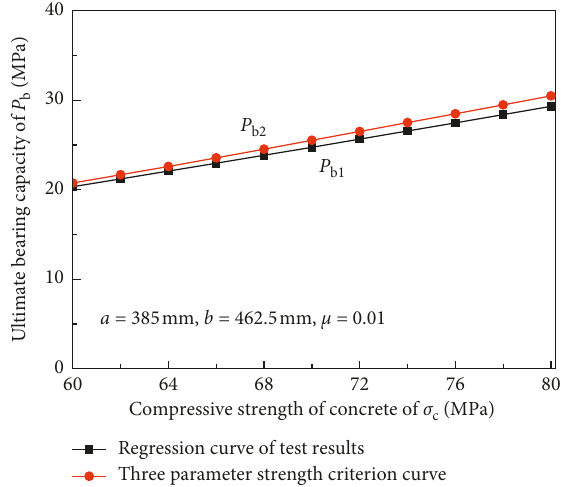
Regression curve of test results Figure 14: The relationship between ultimate bearing capacity and compressive strength when λ 0 . (cid:31)